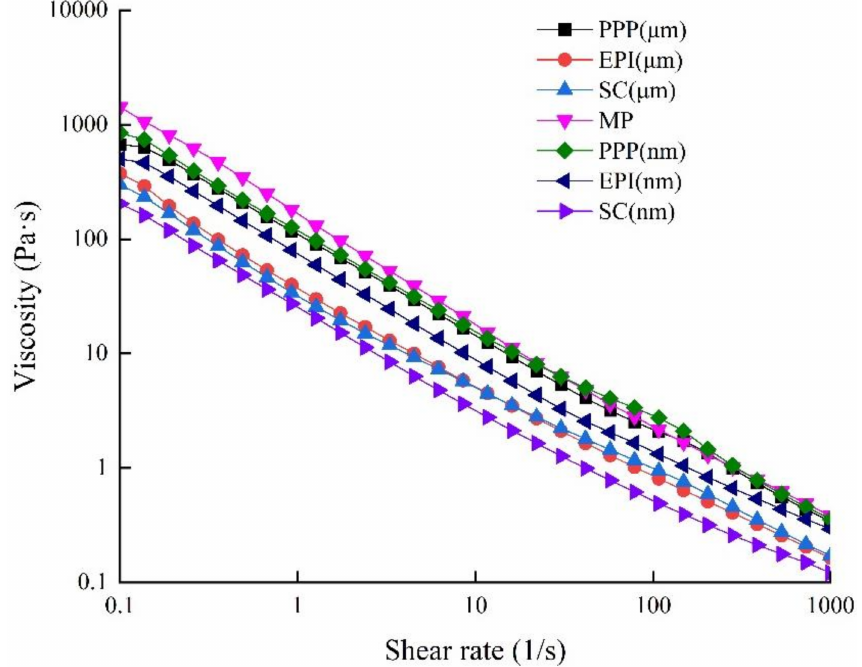
Figure 3. Viscosities of MP-emulsified soybean oil composite sols. PPP: porcine plasma protein; EPI: egg-white protein isolate; SC: sodium caseinate; MP: myofibrillar